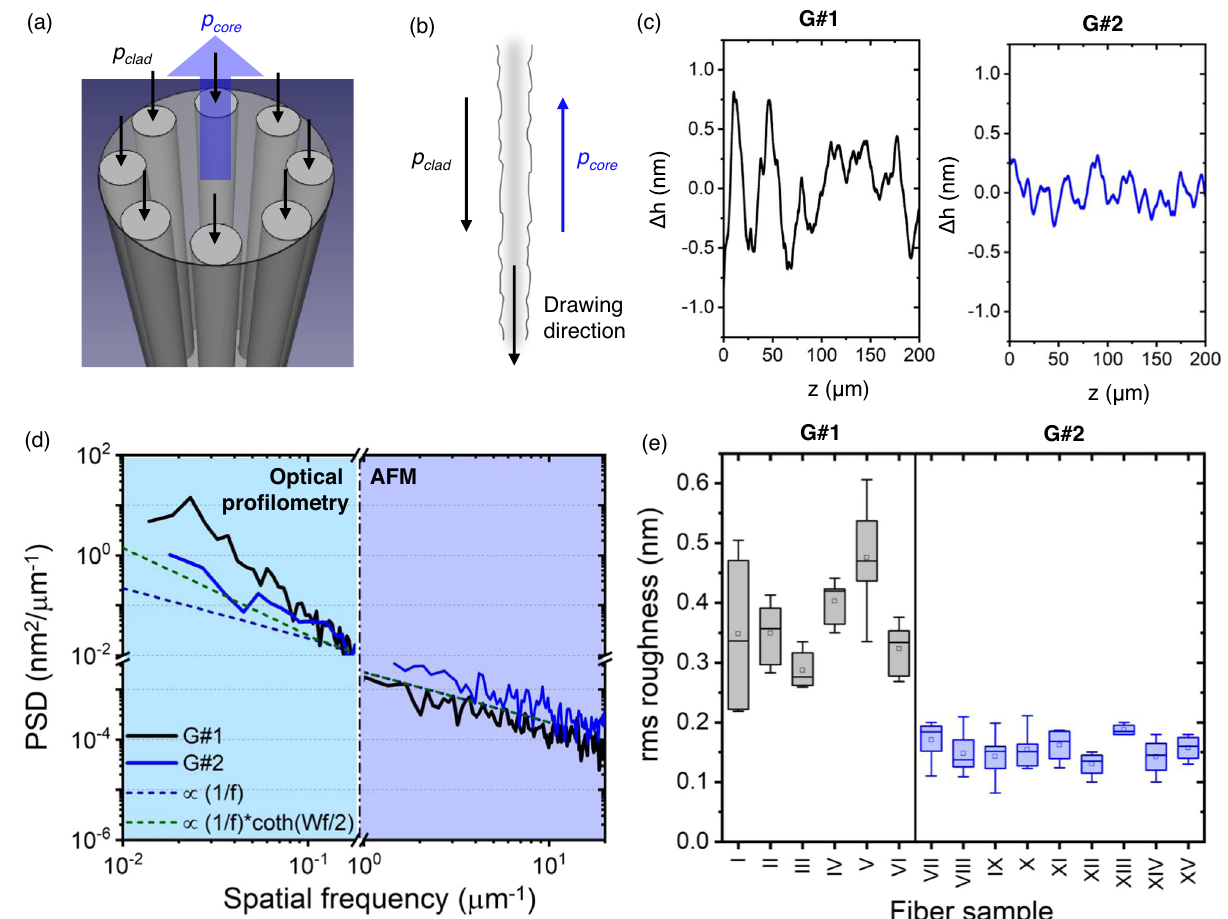
Fig. 3 | Core surfaceroughness reductioninHCPCFs. a Diagram for the pressure application in the fi ber preform during the innovative process proposed in this manuscript; p core pressure in the fi ber core, p clad pressure in the cladding tubes. b Diagram of the interfaces between the surfaces of the cladding tubes, the tubes